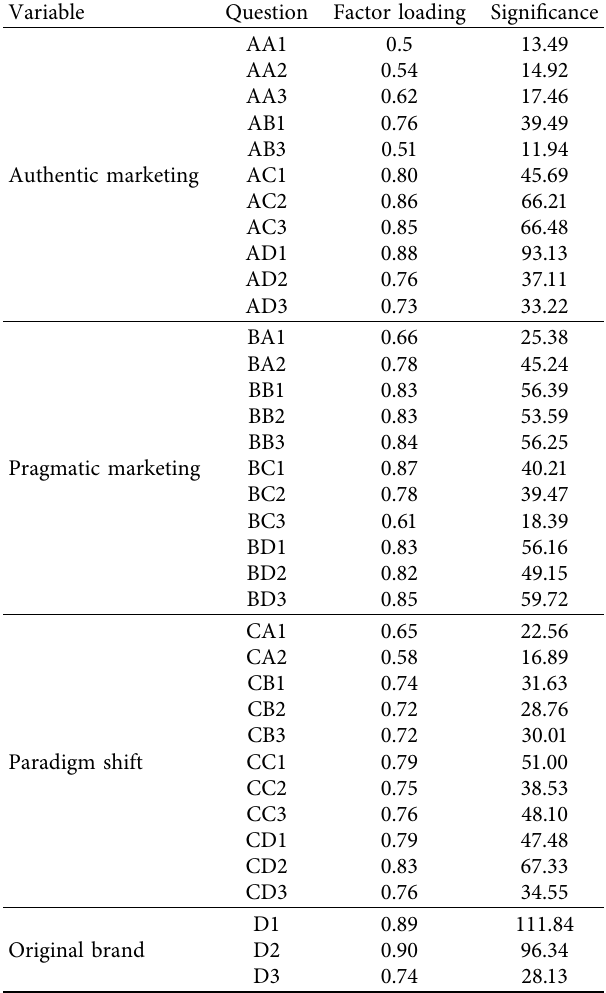
Table 3: Factor loading and significance of questions (first-order